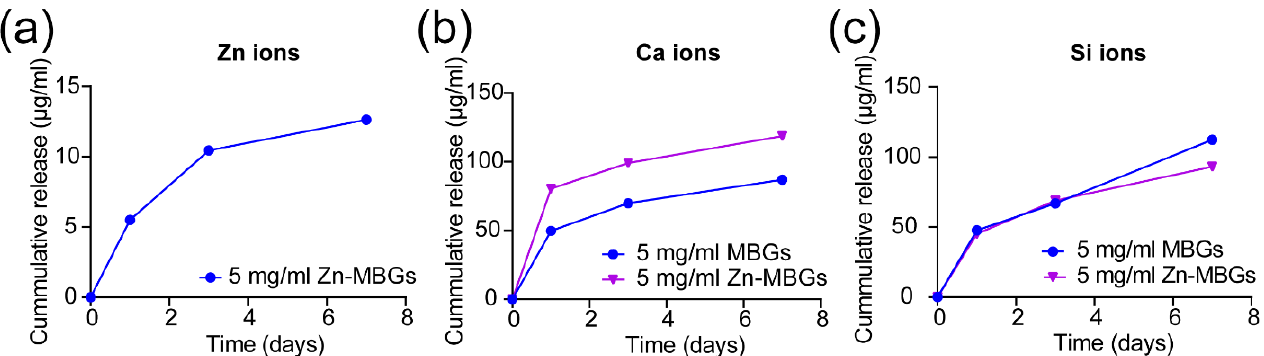
Figure 2. Ion release curves of Zn 2+ ( a ), Ca 2+ ( b ) and Si 4+ ( c ) from Zn-MBGs and MBGs cultured in DMEM at concentration of 5 mg/mL for 1, 3, and 7 days.